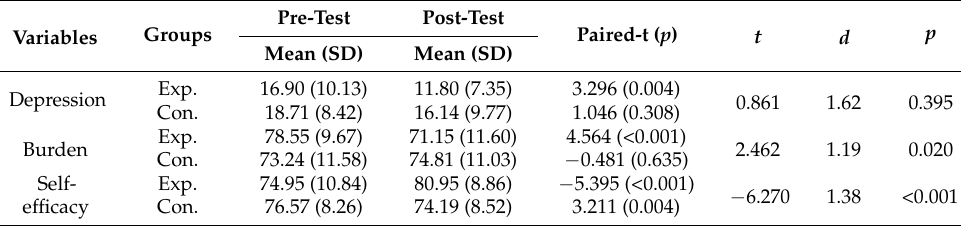
Table 3. Effects of the group art therapy intervention on depression, burden, and self-efficacy ( n = 41).